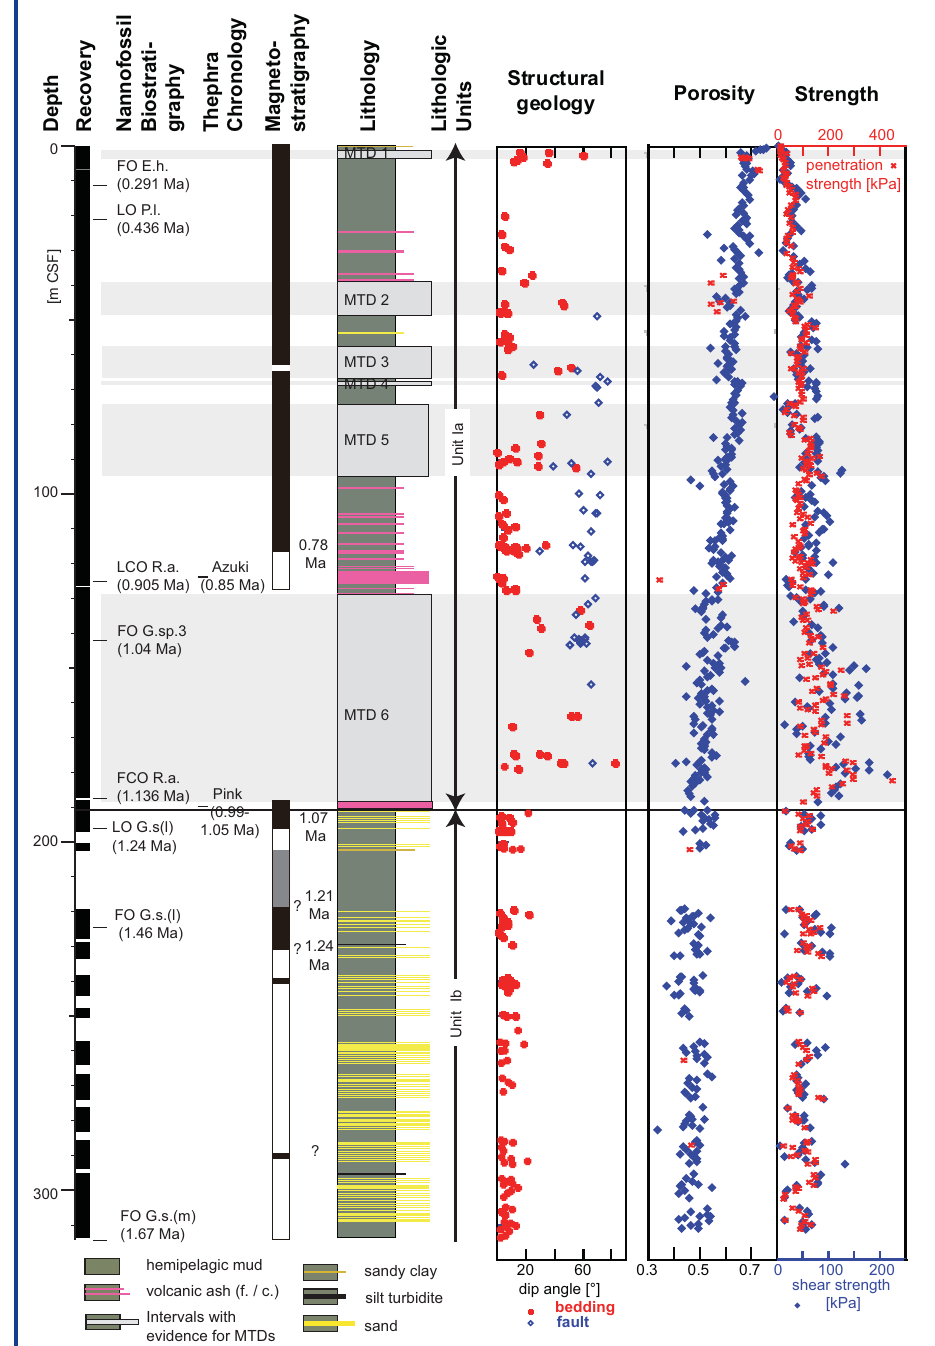
Figure 7. Summary diagram of IODP Expedition 333 Site C0018 shipboard results. Abbreviations for